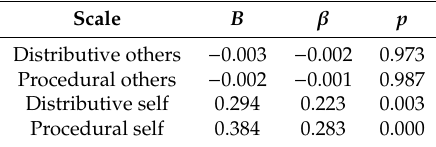
Table 3. Prediction of life satisfaction by BJW